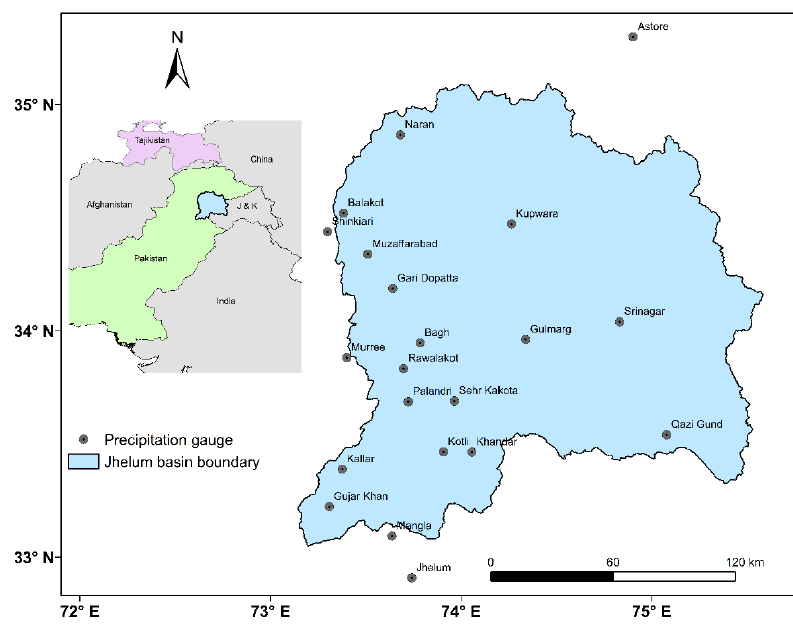
Figure 1. Location map of the study area, the Jhelum River basin, showing precipitation gauges .